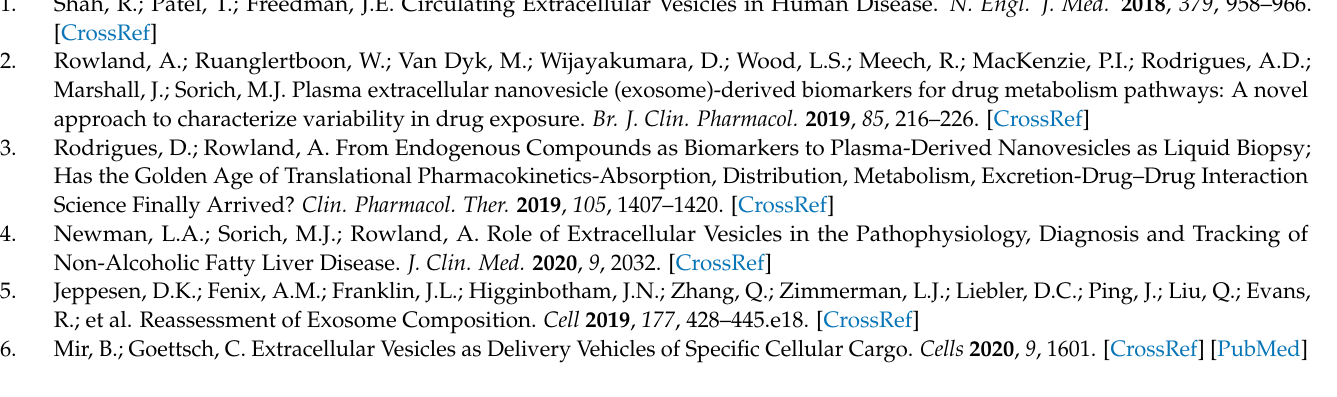
cytometry analysis, Figure S3: Flow cytometry analysis establishing normal ranges of variability on marker abundance, Figure S4: Flow cytometry analysis investigating the impact of fasting on EV marker abundance, Figure S5: Flow cytometry analysis investigating diurnal impact on EV marker abundances, Figure S6: Flow cytometry analysis investigating impact of sex on EV marker abundance. Supplementary Table S1: Analyte peptide